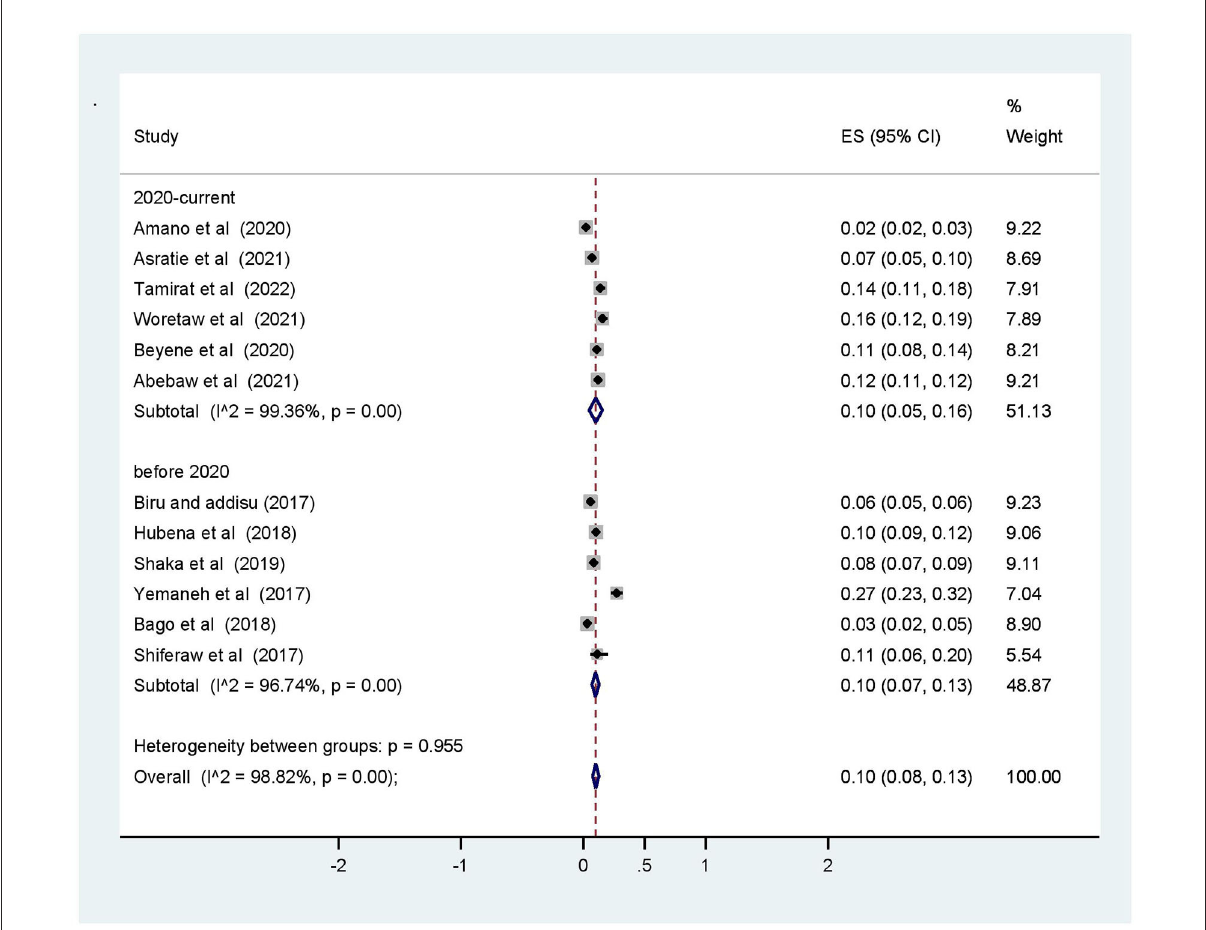
FIGURE5 Subgroup analysis based on year of publication for operative vaginal deliveries among mothers who gave birth in Ethiopia,